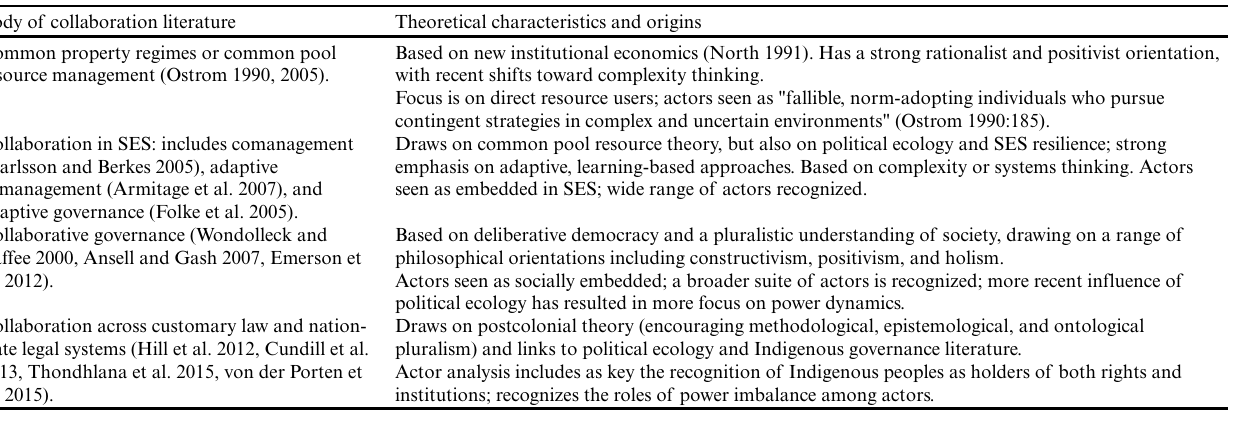
Table 2 . Four distinct bodies of literature relevant to understanding collaboration in social-ecological systems (adapted from Sandström 2009, Saunders 2014, Cleaver and Whaley 2018, and Cockburn et al.